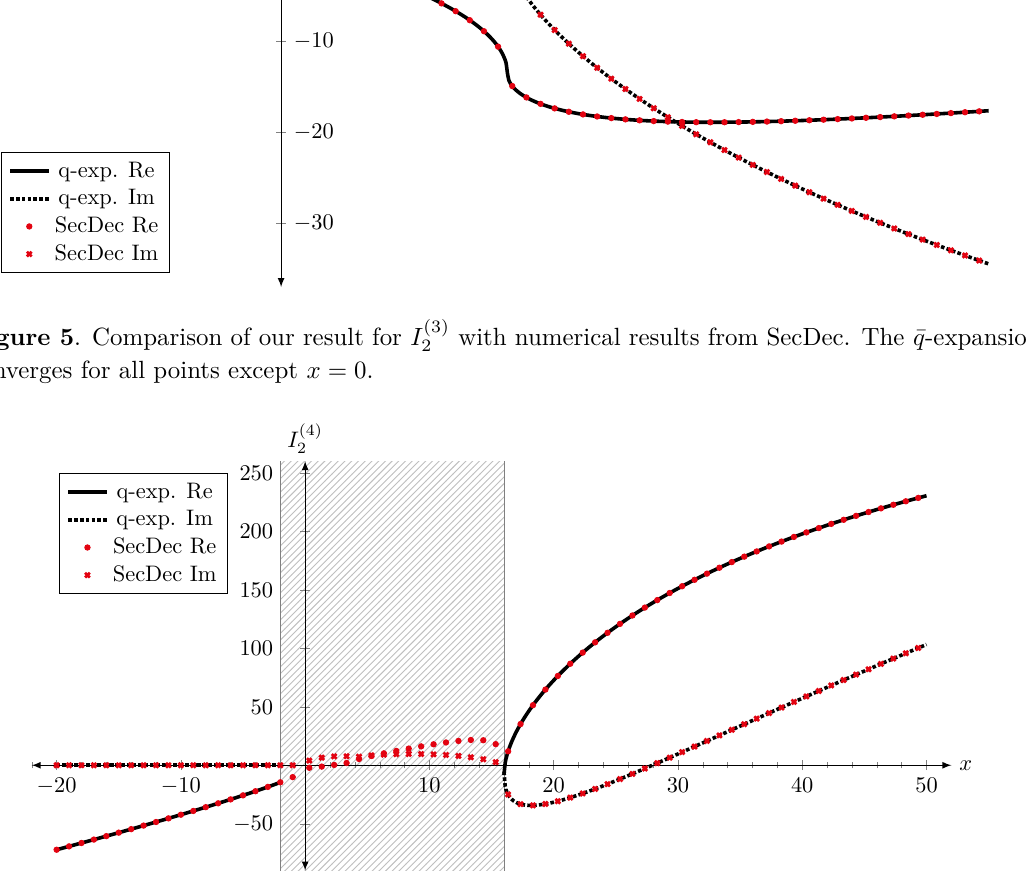
Figure 6 . Comparison of our result for I (4) with numerical results from SecDec. The ¯ q -expansion 2 converges for x < − 2 and x > 16 . In the interval [ − 2 , 16] only the points from SecDec are